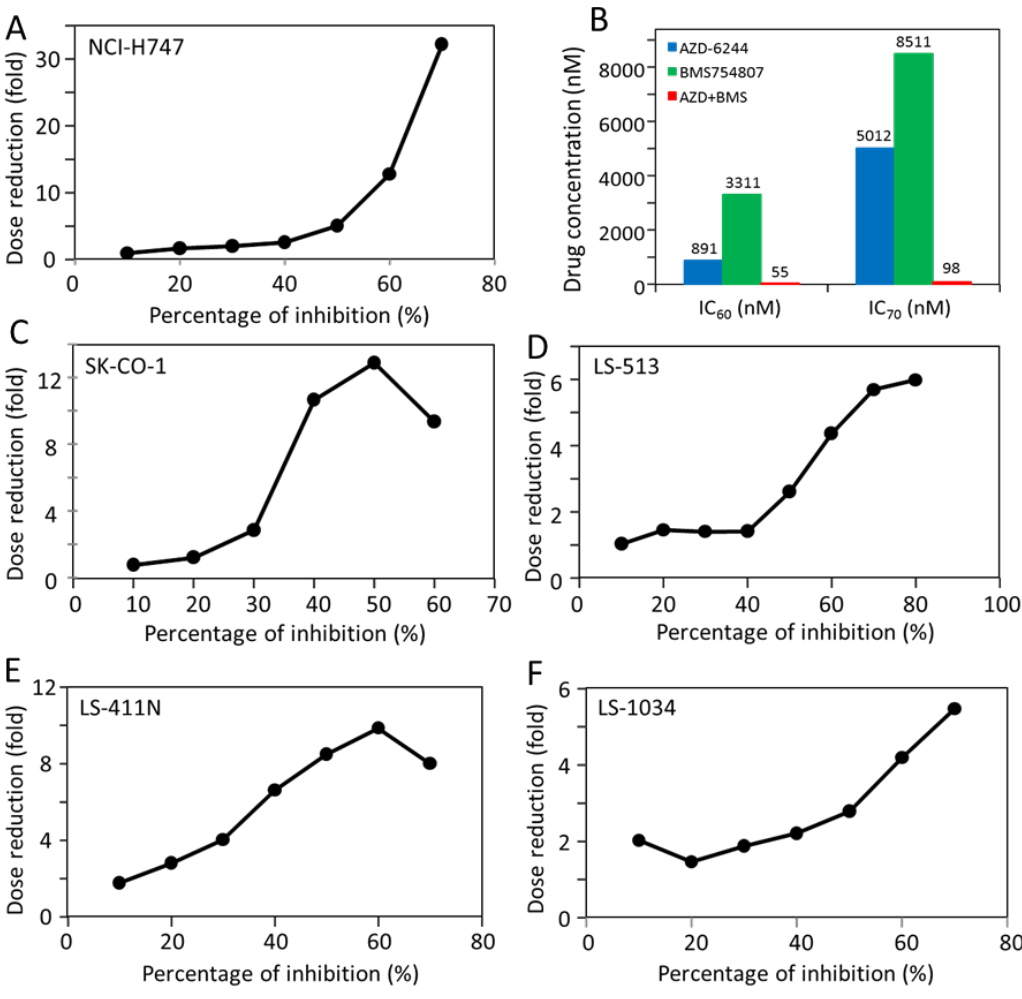
Figure 5. Correlation between the combination synergy and the percentage of inhibition. ( A , C – F ) Dose reduction index for the AZD-6244 and BMS-754807 combination as a function of the percentage of inhibition in indicated cell lines. The dose reduction indexes were calculated as described in Materials and Methods using the data presented in Figure 4B, IC 60 and IC 70 of NCI-H747 for AZD-6244, BMS-754807 and the combination of the two drugs. The dose reduction indexes, the IC 60 and IC 70 values reported in these graphs are derived from the data presented in Figure 4. Because statistical analysis was performed in Figure 4, no additional statistical analysis was performed